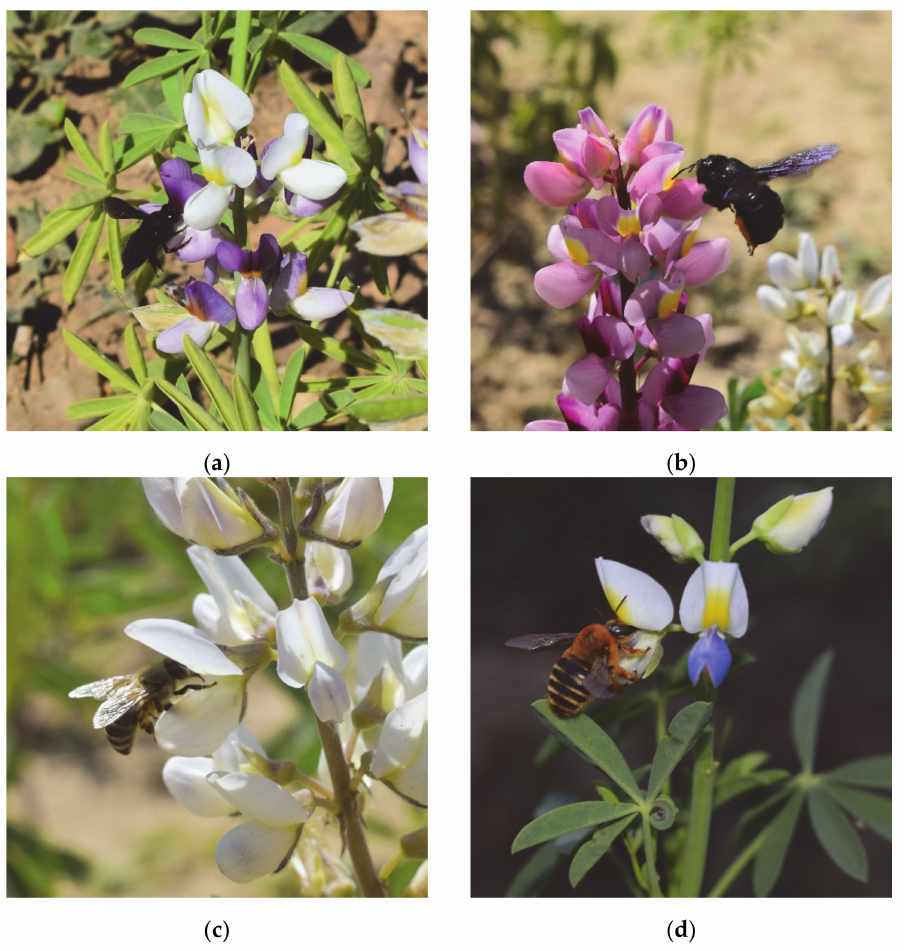
Figure 4. ( a ) Megachile sp. bee foraging on a L. mutabilis flower; ( b ) Xylocopa sp. bee foraging on a L. mutabilis flower; ( c ) Apis melifera . bee foraging on a L. albus flower; ( d ) Anthophora sp. bee foraging on a L. mutabilis